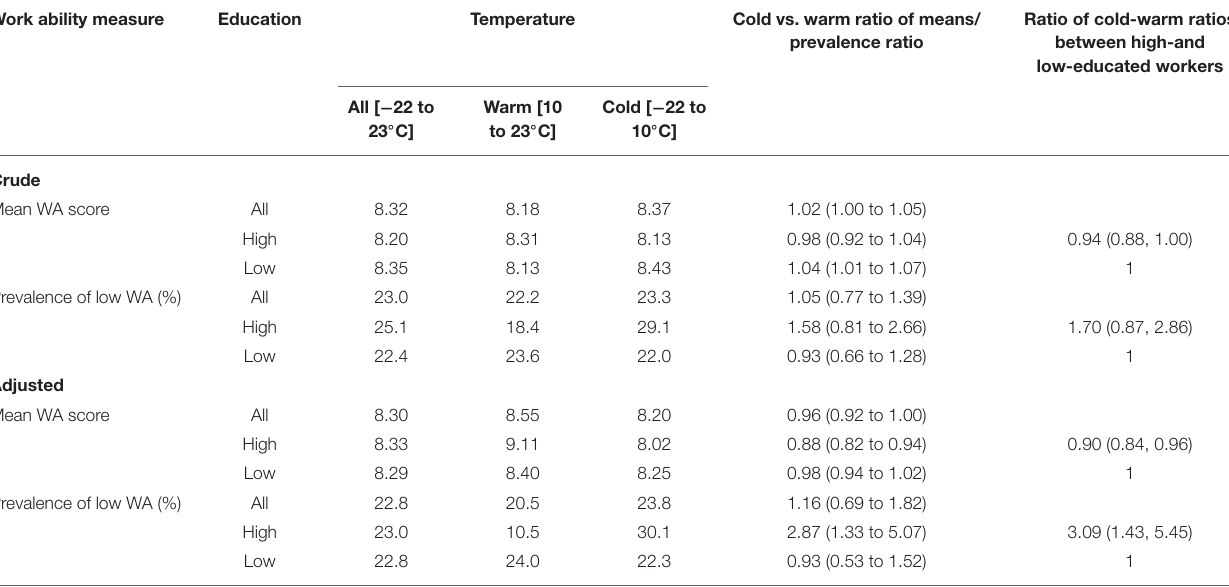
TABLE 2 | Crude and model-based adjusted a work ability (WA) score and prevalence of low WA ( < 8) according to worksite temperature and education. Work ability measure Education Temperature Cold vs. warm ratio of means/